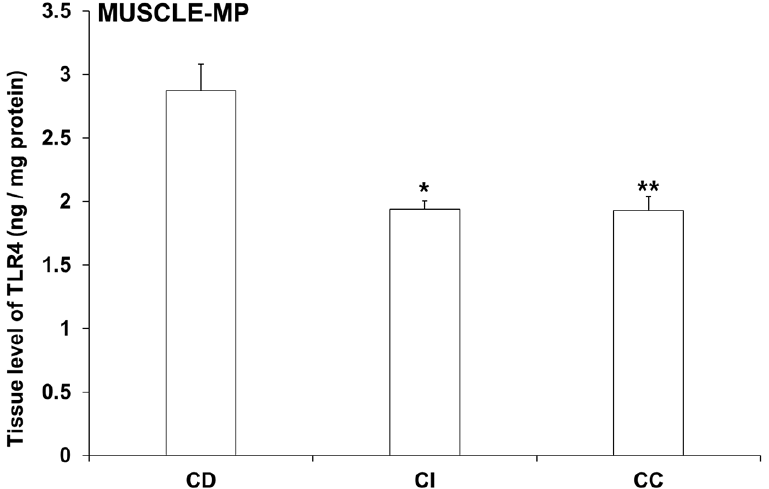
Figure 8. Tissue levels of TLR4 in intestinal smooth muscle layer homogenates including the myen- teric plexus from different gut segments of control rats. The TLR4 level was highest in the duodenum, while it was significantly lower in the ileum and colon of controls. Statistics: Kruskal-Wallis test with Dunn’s multiple comparisons test. Data are expressed as means ± SEM. * p < 0.05, ** p < 0.01 (relative to control duodenum). CD—control duodenum, CI—control ileum, CC—control co- lon.